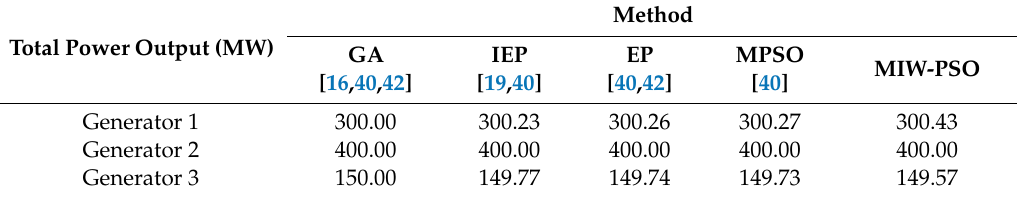
Table 5. Comparison of generator power output on the second case